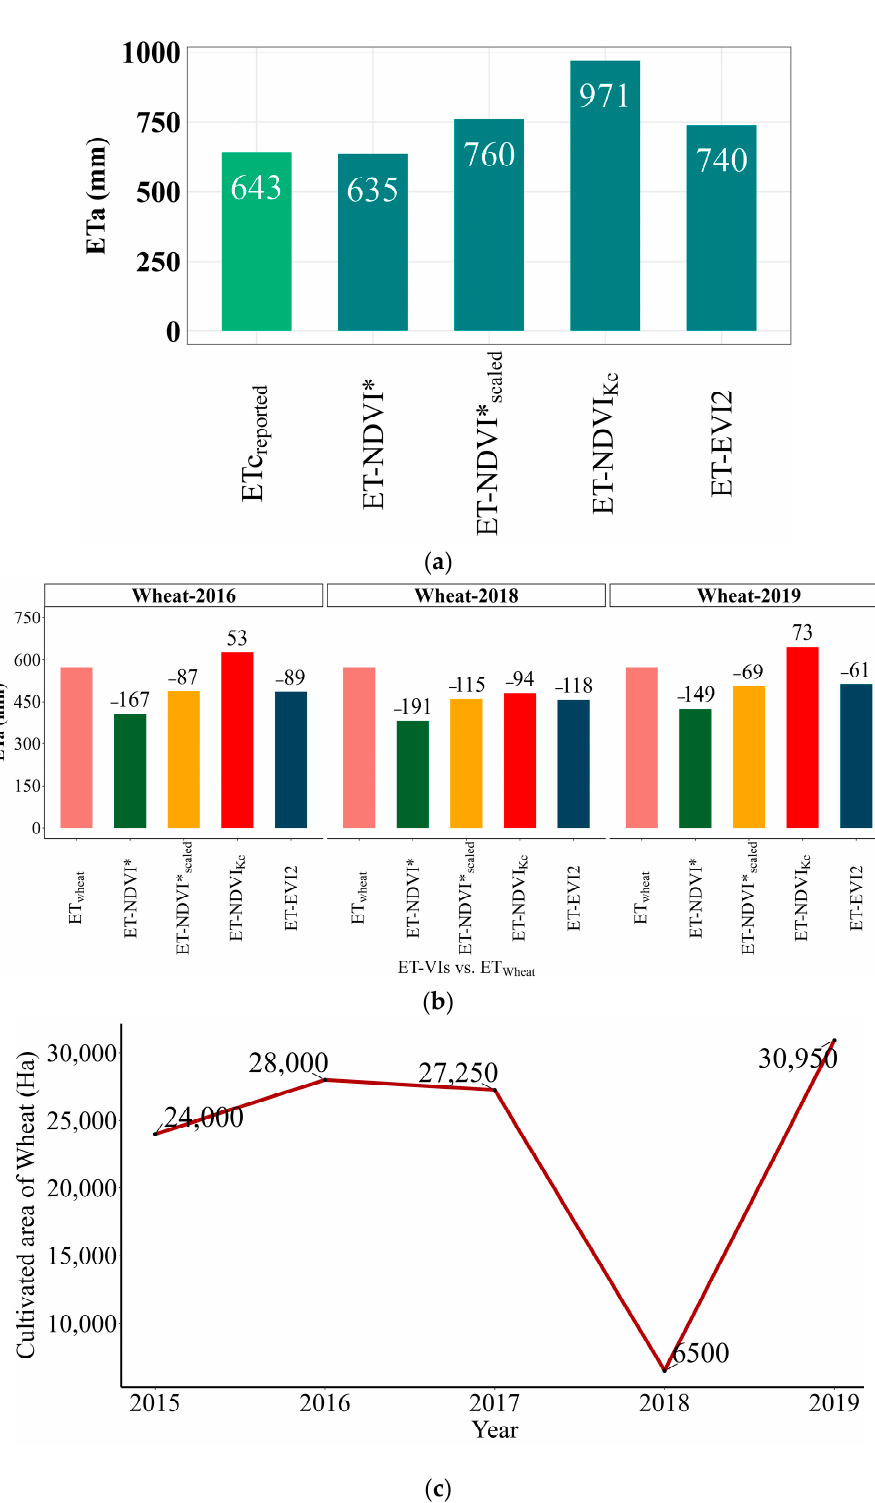
Figure 5. Comparing ET-VIs with ETc and ETwheat: ( a ) Comparing long-term average ET-VIs with reported ETc; light green: growing season scale; dark green: annual scale. ( b ) Comparing ET-VIs with ETwheat within three different growing seasons; numbers on bars show the difference between ET-VIs and ETwheat, and ( c ) Cultivated area of wheat from 2015 to 2019. In the dry year of 2018, ET-VIs are lower than the reported ET wheat . In 2016, the differ- ences in ET-VIs are close to their corresponding values in 2019. Figure 5a and 5b show